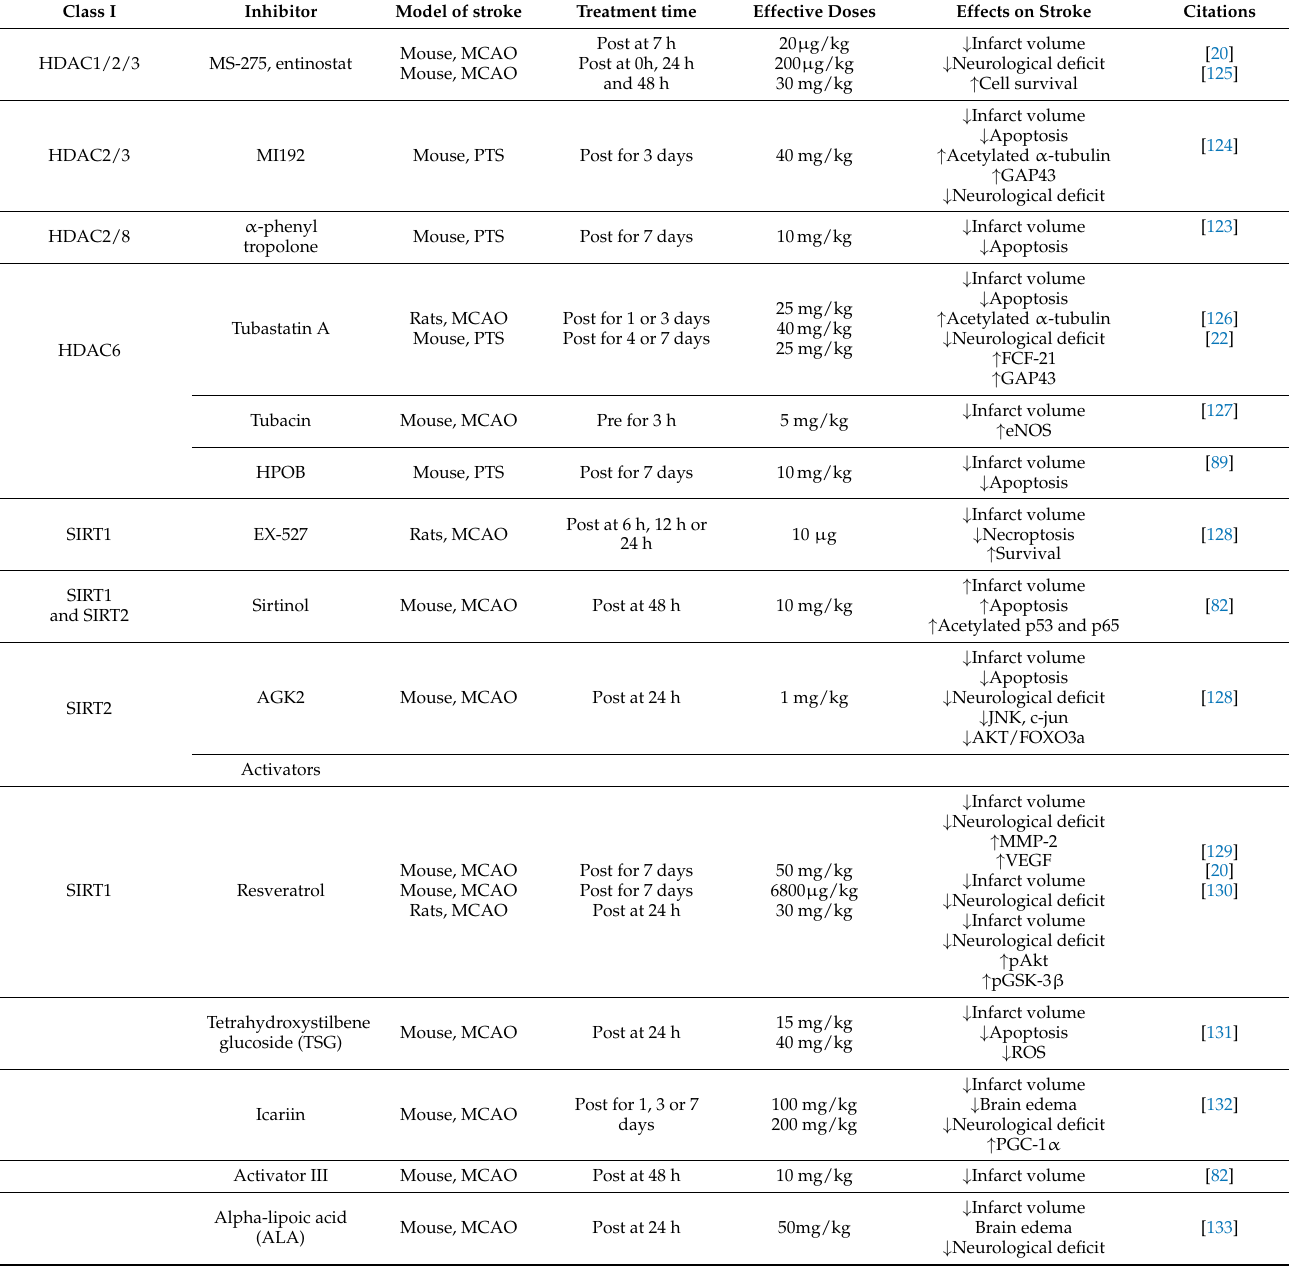
Table 1. Effects of selective HDAC inhibitors and activators in animal models of ischemic